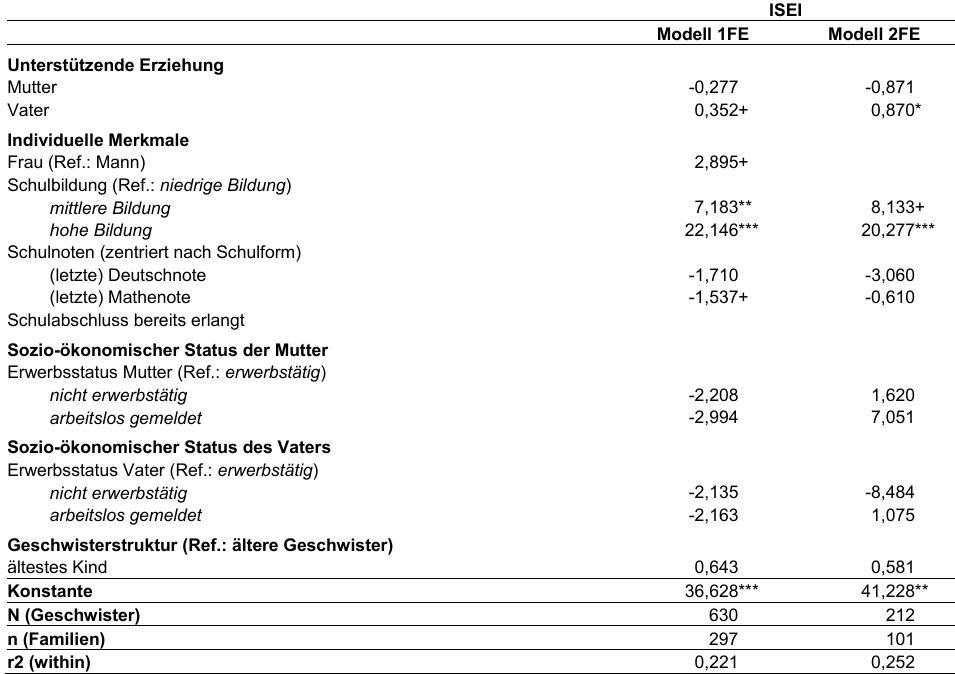
Tabelle 3 : Fixed-Effects-Regressionsmodelle zu den Einflussfaktoren der beruflichen Aspirationen von